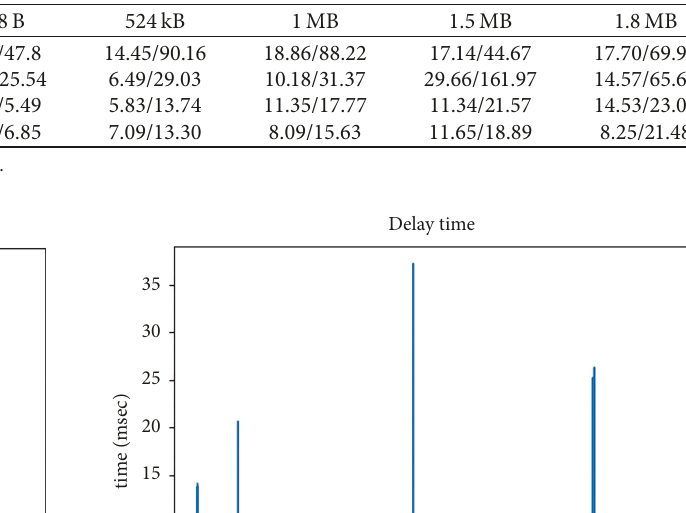
Table 3: Mean and maximum delay with different message